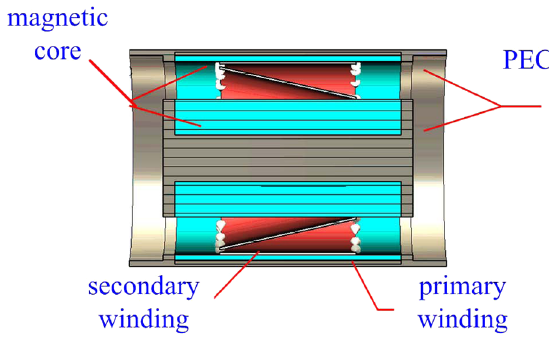
FIG. 5. Model in the finite elemental magnetostatic-field simu- lations for case 1.